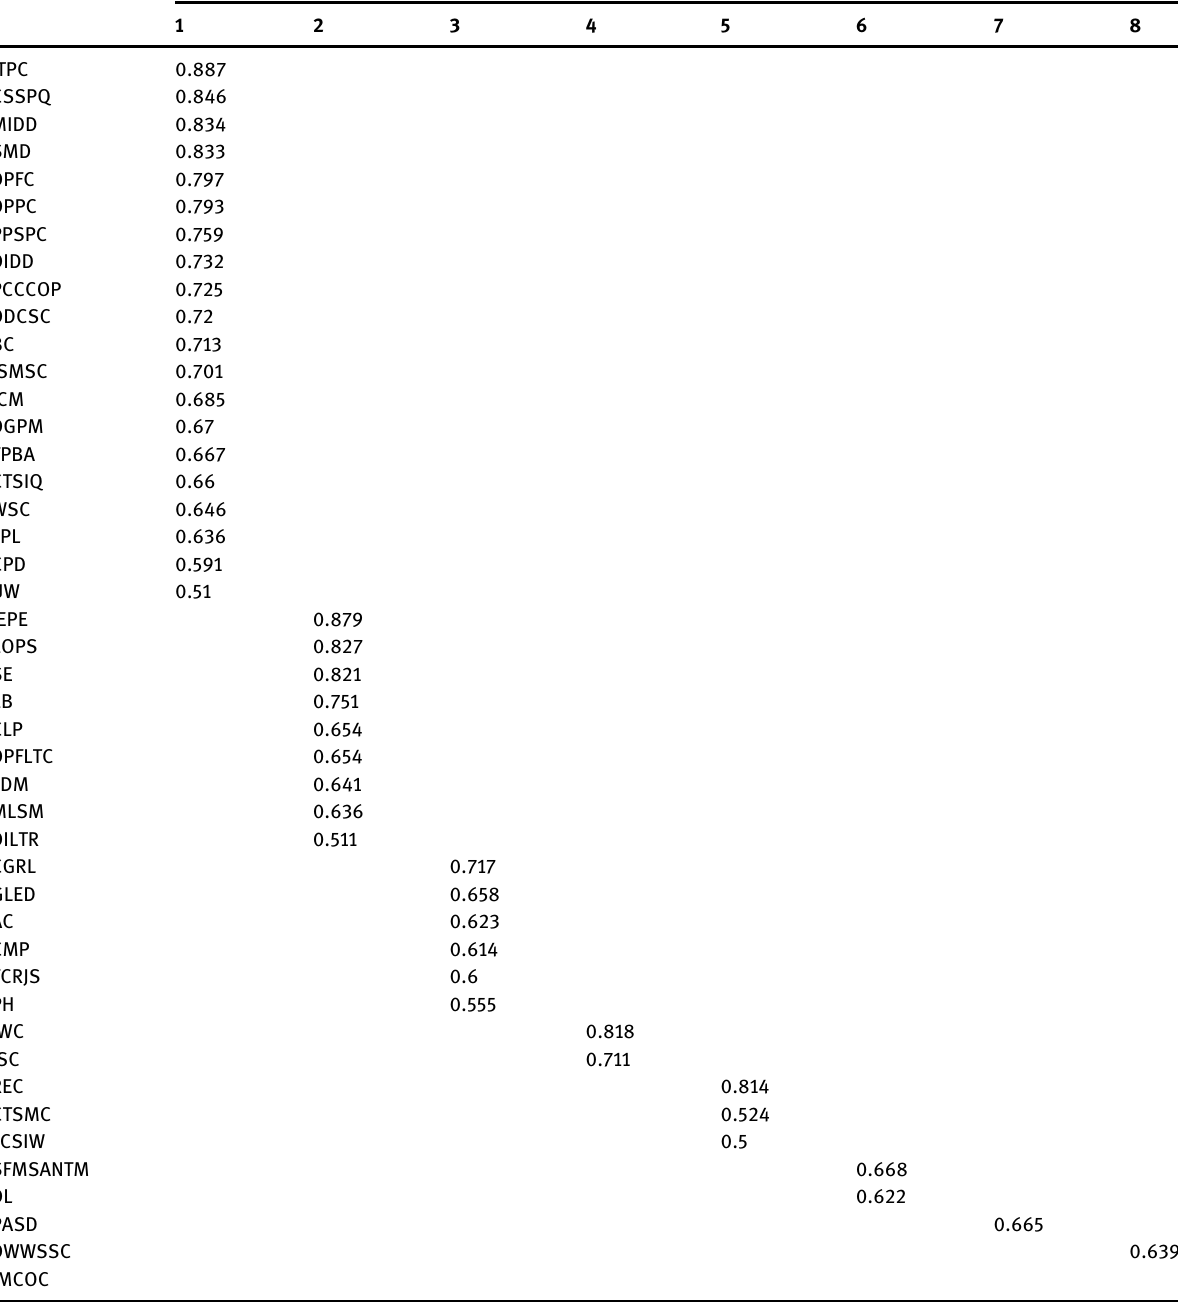
Table 9: Factor analysis outputs of the factor loadings